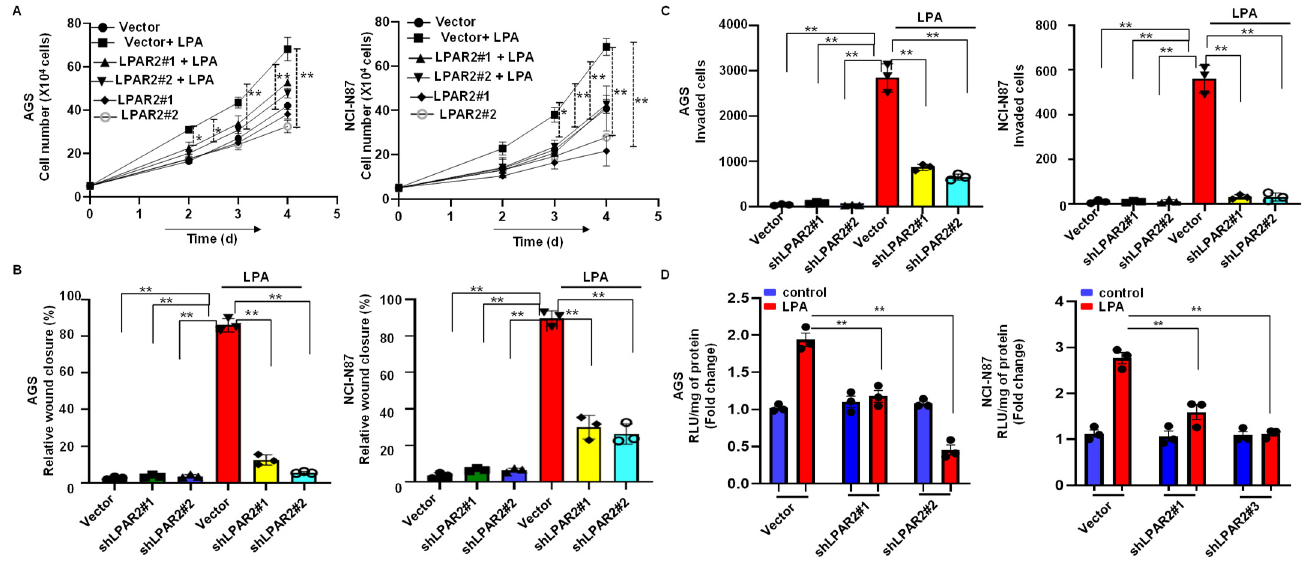
Figure 4. LPAR2 knockdown reduced LPA-induced proliferation, migration, invasion activity, and activation of the β -catenin signaling pathway in the gastric cancer cell. ( A ) AGS ( left ) or NCI-N87 ( right ) cells were lentivirally transduced with vector or three LPAR2-shRNA and subsequently investigated for LPA-induced proliferation using a hemocytometer. ( B , C ) LPA-induced migration and invasive activity was reduced in LPAR2 knockdown AGS ( left ) or NCI-N87 ( right ) cells. ( D ) LPAR2 knockdown reduced LPA-induced β -catenin activity in the AGS ( left ) and NCI-N87 ( right ) cell lines. All values are mean ± SD ( n = 3). * p < 0.05, ** p < 0.01 compared to the control. Student’s t -test was used for comparisons between the two groups; one-way ANOVA followed by the Bonferroni post hoc test was performed for more than two groups.